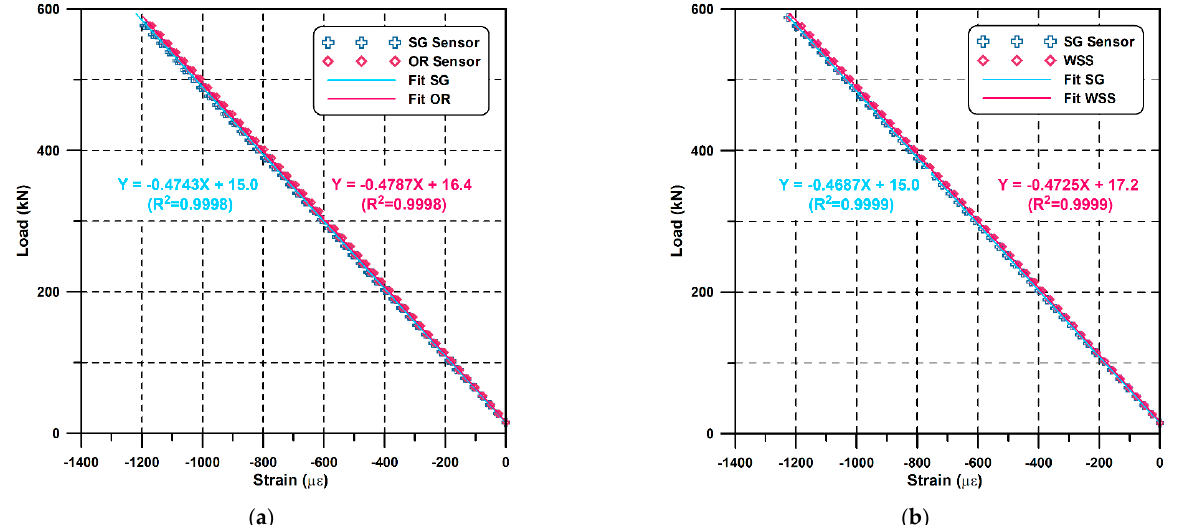
the protection, with a high fidelity of R 2 values of 0.9998 and 0.9999, respectively, which indicates that sensor protection does not affect the sensor response characteristics.